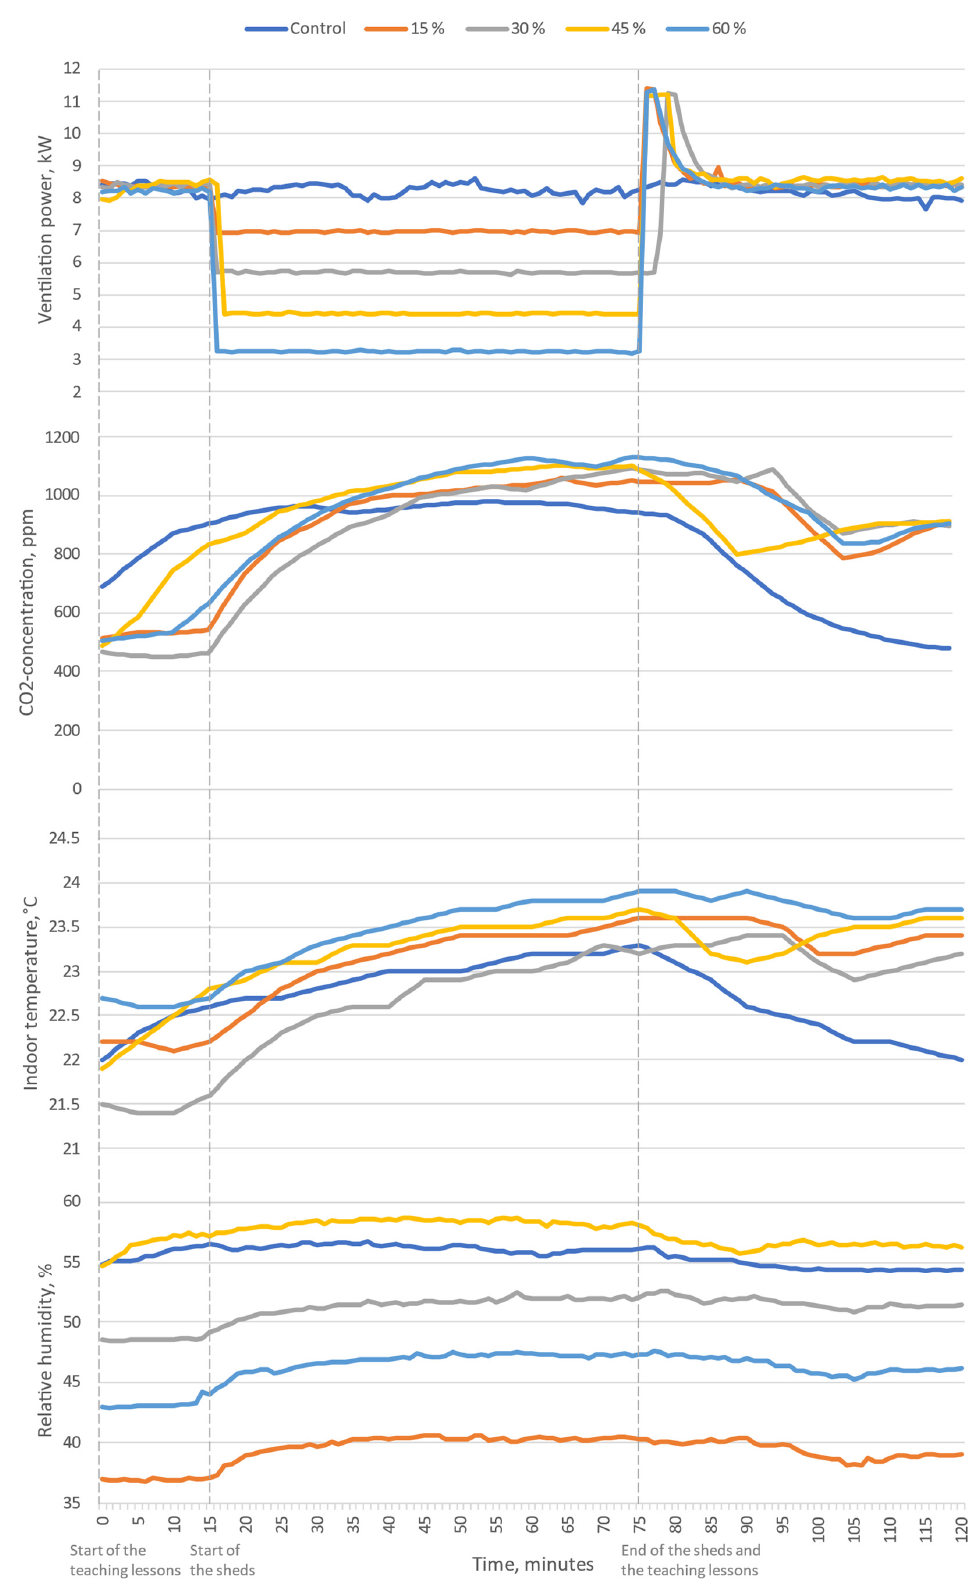
Figure 5. The ventilation power and the indoor CO 2 -concentration, the temperature and the relative humidity data obtained from the 60 min tests.